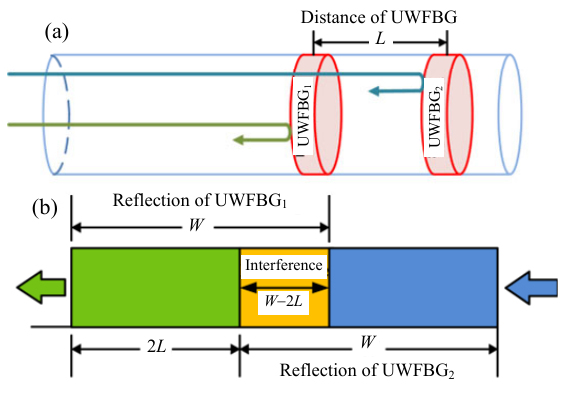
Fig. 8 Schematic diagram: (a) UWFBGs used as weak re fl ector to create a Fizeau interferometer in fi ber and (b) when the injected optical pulse length is wider than 2 L , parts of these two re fl ections will overlap with each other and generate an interference signal [50]